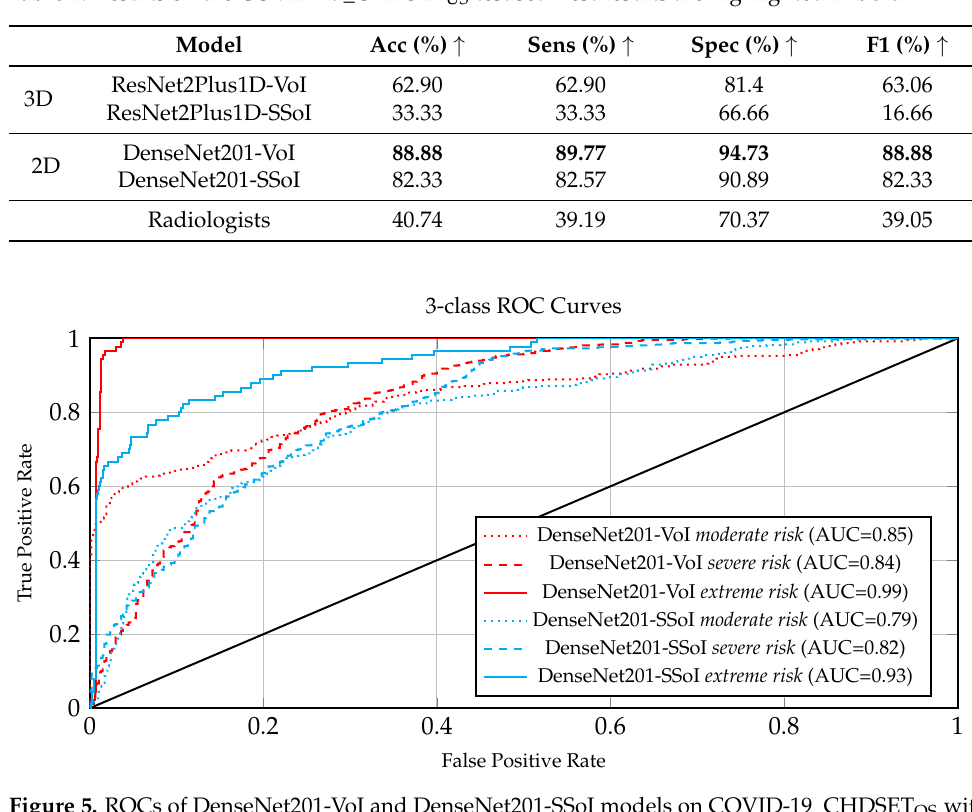
Table 4. Results on the COVID-19_CHDSET US test set. Best results are highlighted in bold .